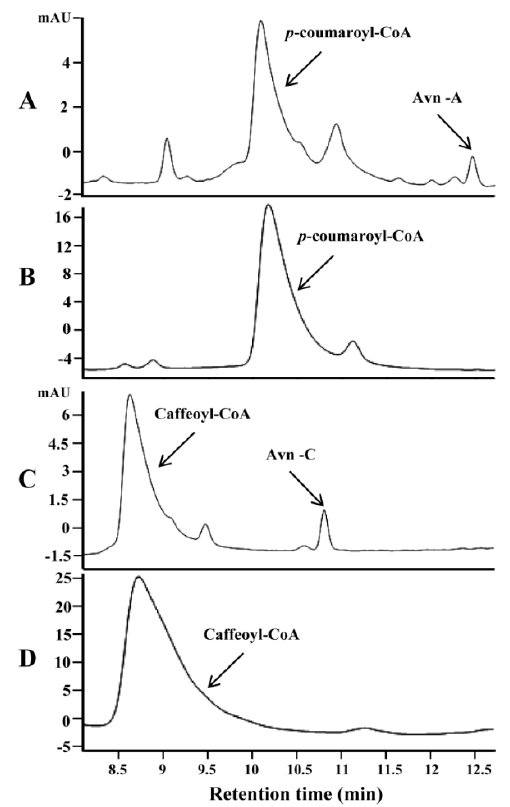
Figure 2. In vitro assays of oat HHT gene (AsHHT1) using the protein expressed in E. coli . HPLC analysis of the products in the presence of 5-hydroxy-anthranilic acid with p -coumaroyl-CoA ( A ) and with caffeoyl-CoA ( C ). The negative controls with boiled AsHHT enzymes were shown in ( B , D ) with corresponding substrates.